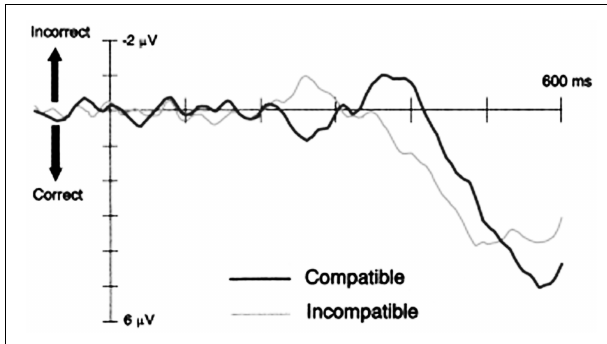
FIGURE 1 | Lateralised readiness potentials for compatible and incompatible trials from Experiment 2 of Eimer and Schlaghecken